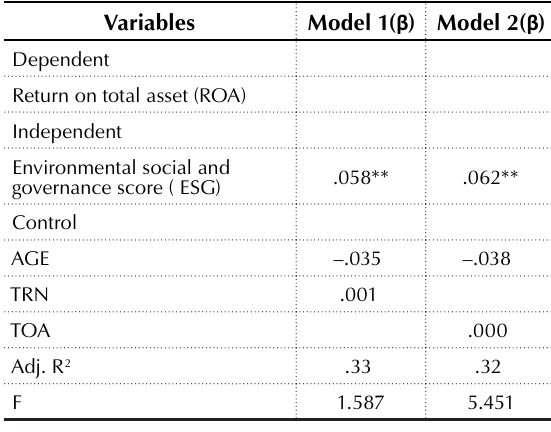
Table 3. Results of the regression analysis for ESG as an independent variable